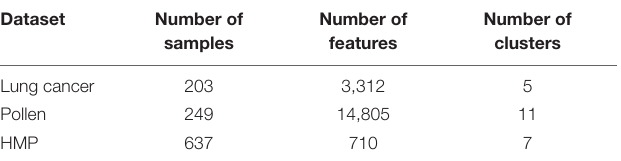
TABLE 1 | Statistics of the two datasets. Dataset